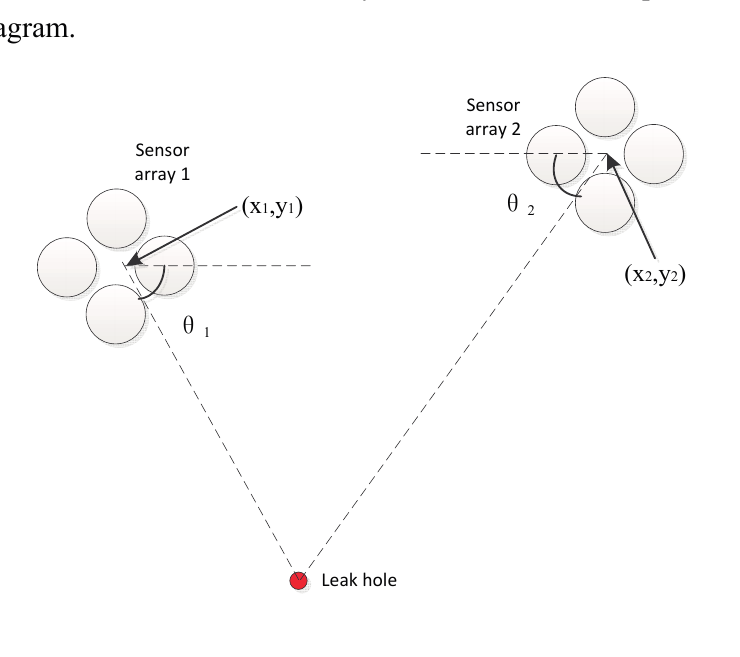
Figure 1. Locating principle